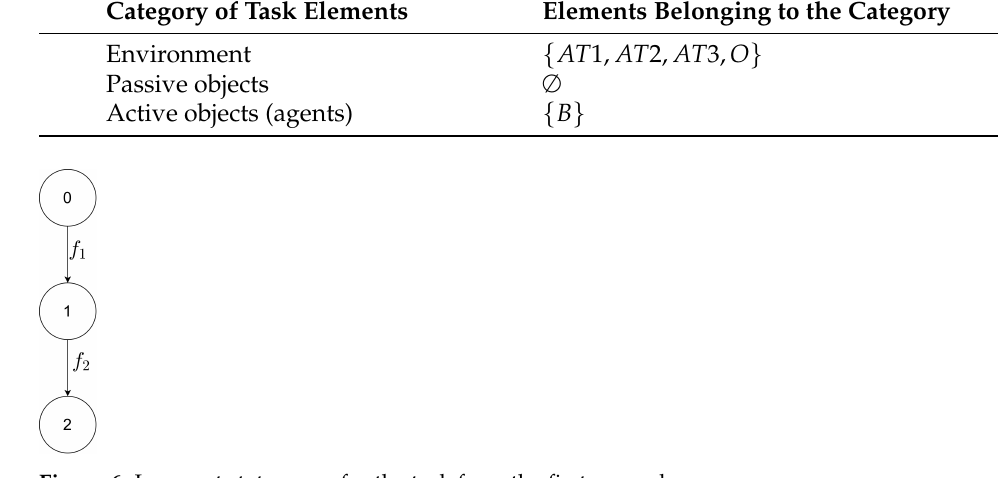
Figure 6. Incorrect state space for the task from the first